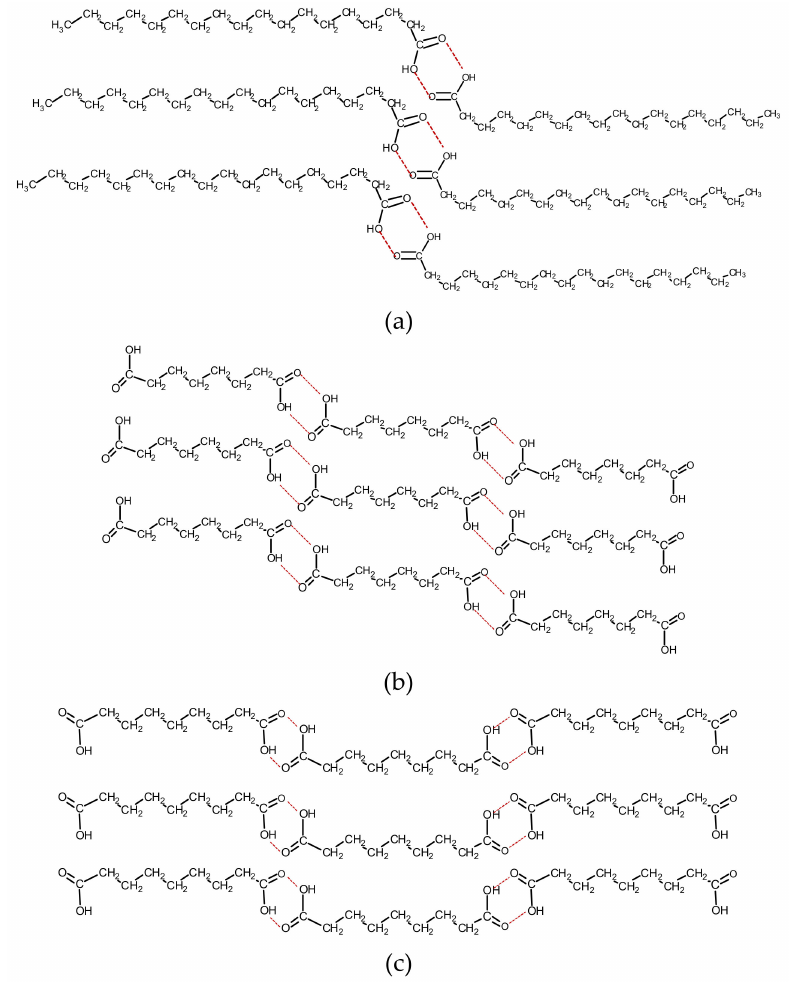
Figure 1. Molecular conformations of fatty acids. ( a ) Type B structure of stearic acid (adapted from [94]); ( b ) octanedioic acid (C8di) and ( c ) nonanedioic acid (C9di) (adapted from